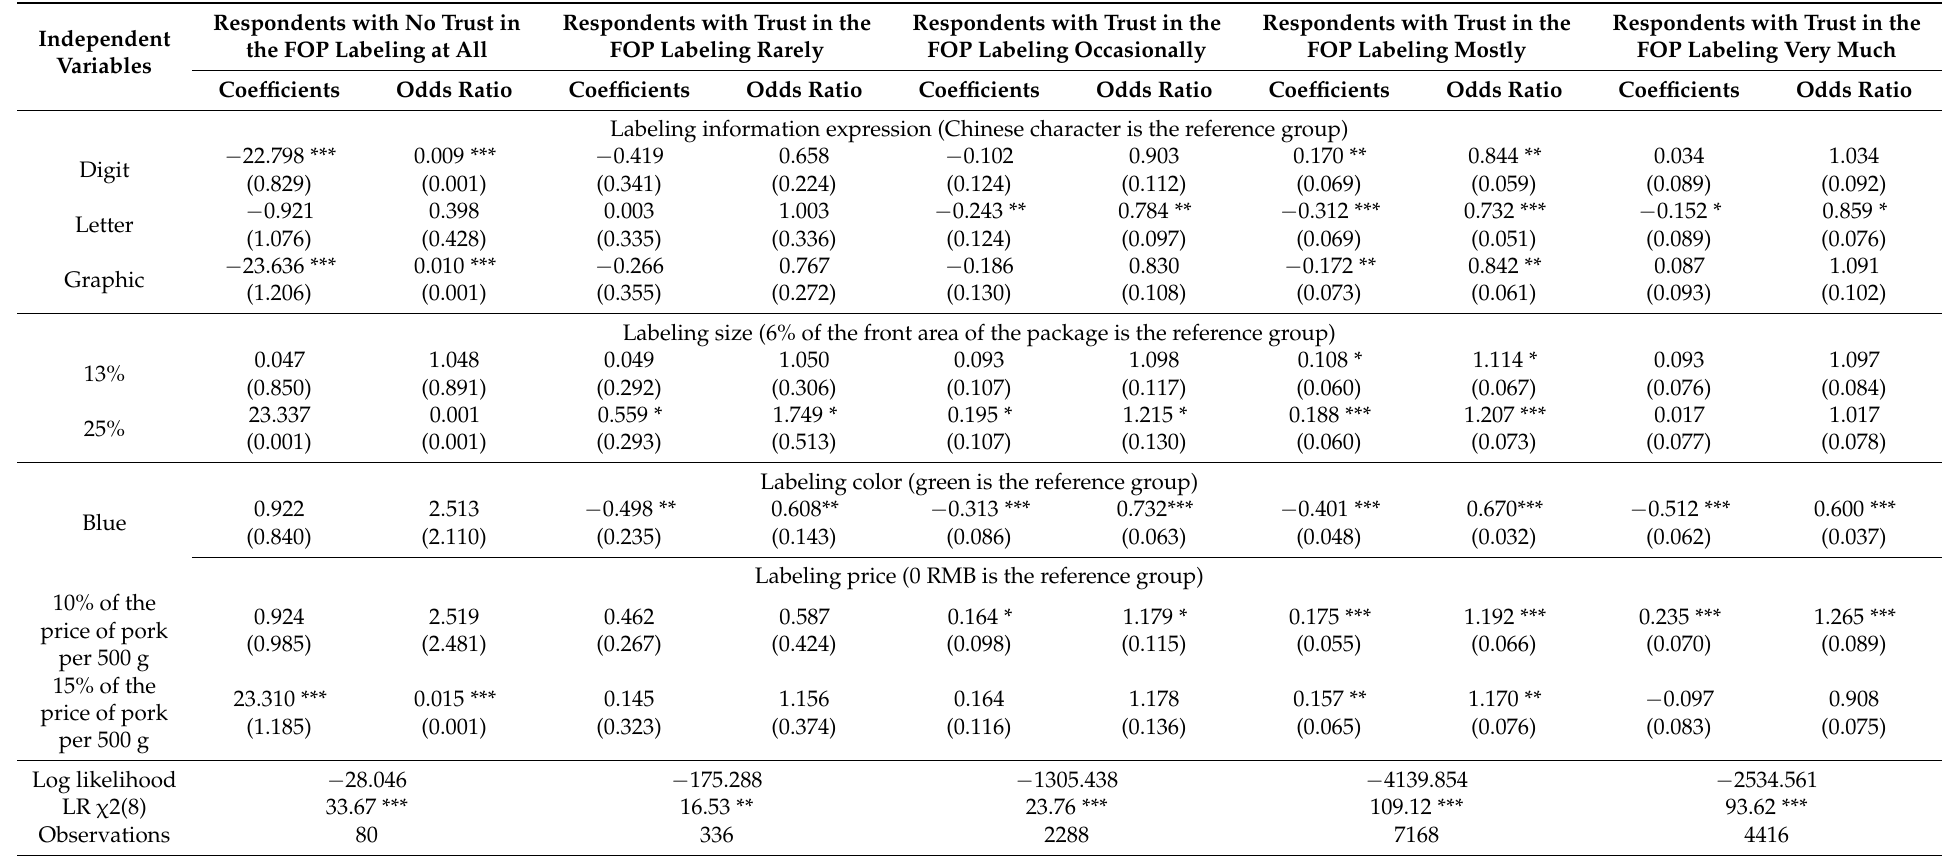
Table 9. Respondents with different trust degrees in the FOP labeling as determined by the conditional logit